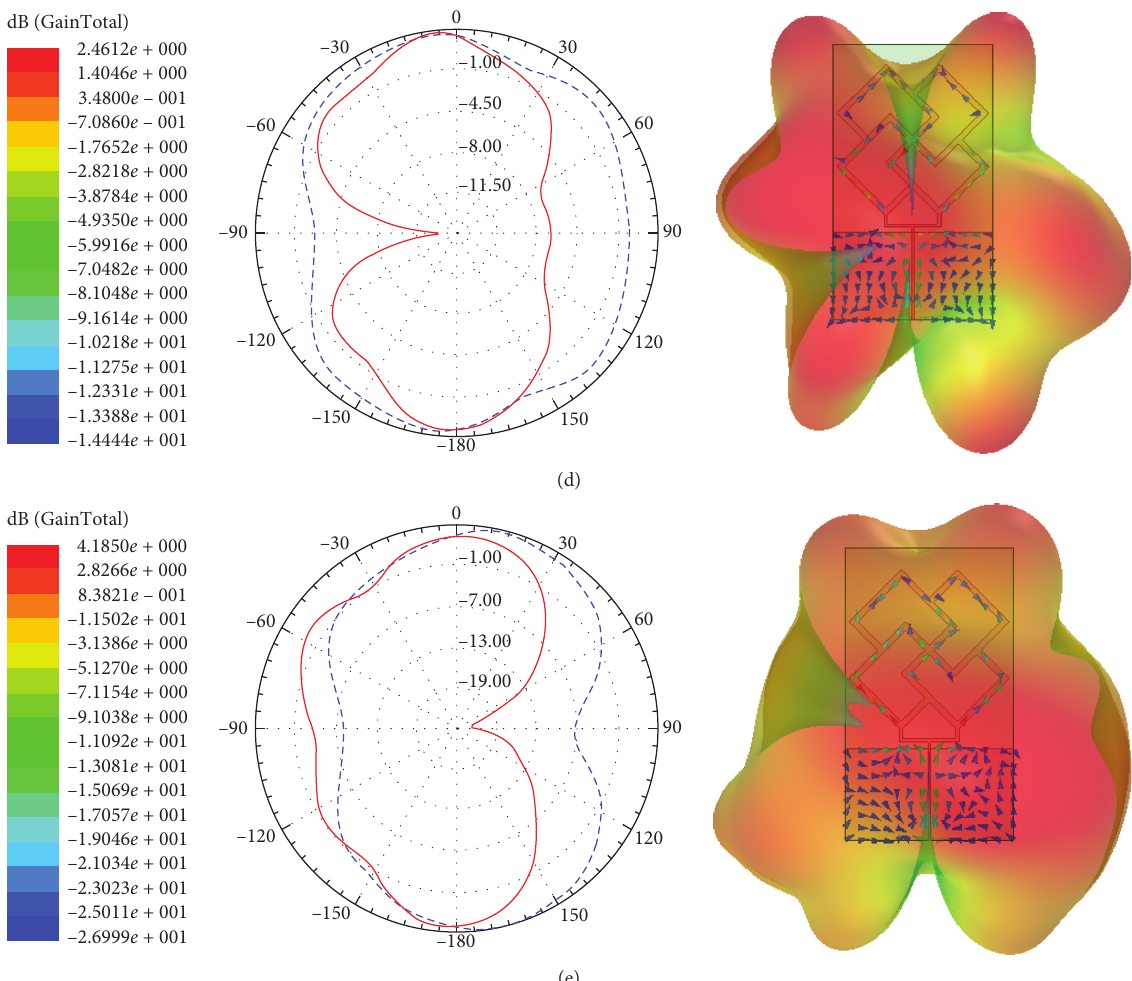
Figure 15: Pattern gain and E/H pattern of a microstrip antenna with a cross structure imitating classical grilles. (a) 1.45GHz,(b) 2.45GHz, (c) 3.85GHz,(d) 5.13GHz, and (e) 5.80GHz.